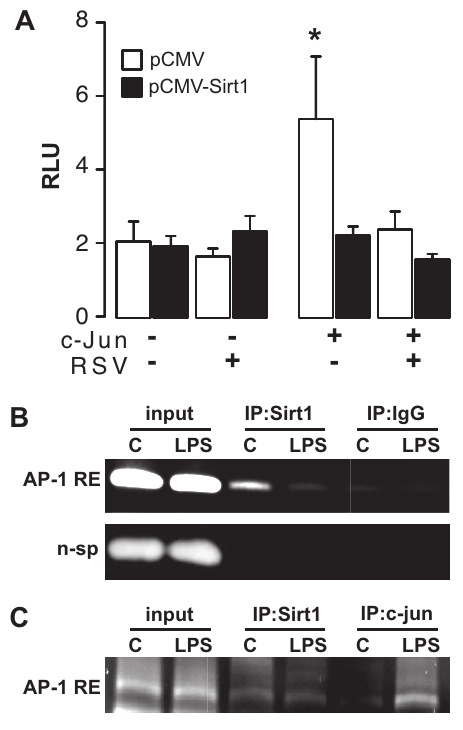
Figure 4. Repression of the human resistin promoter by Sirt1. A , Gene reporter assays using 3.0 kb of the human resistin promoter in 293 T cells transfected with c-Jun, Sirt1 or empty control plasmids and treated for 24 h with resveratrol (20 m M) or vehicle before quantifica- tion of the luminescent signal. Bars are representative of 3 experiments done in triplicate. * indicates a significant difference between groups. B-C , ChIP assay of the AP-1 response element on the resistin promoter using antibodies against Sirt1, IgG, or c-jun on U-937 cells treated with 1 m g/ml LPS or vehicle for 24 h.